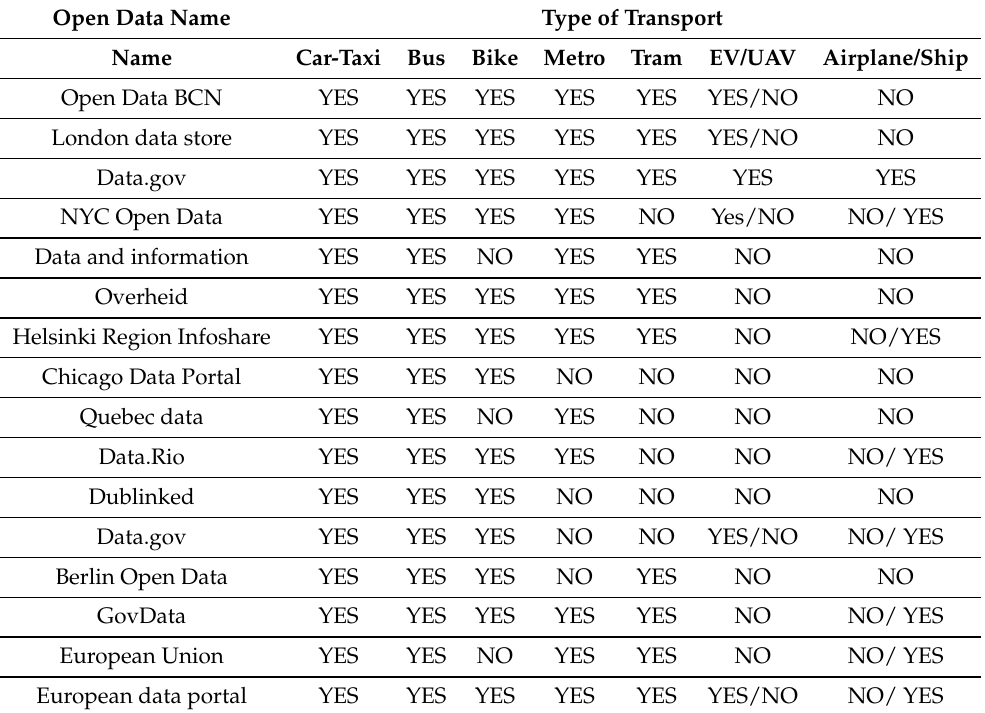
Table 3. Availability of open data initiatives in smart cities by each type of